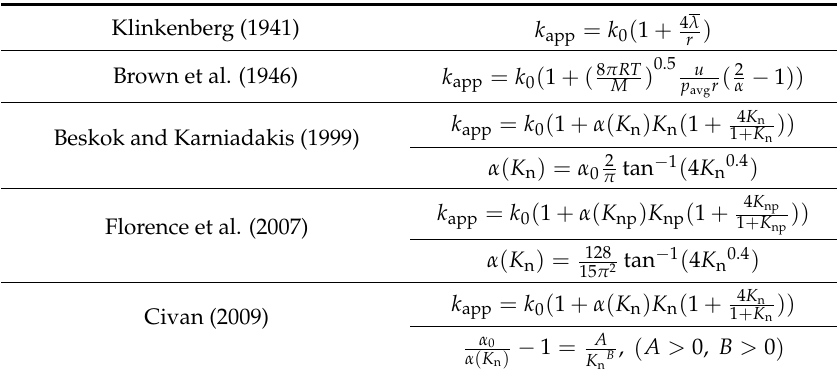
Table 2. Mathematical models of apparent